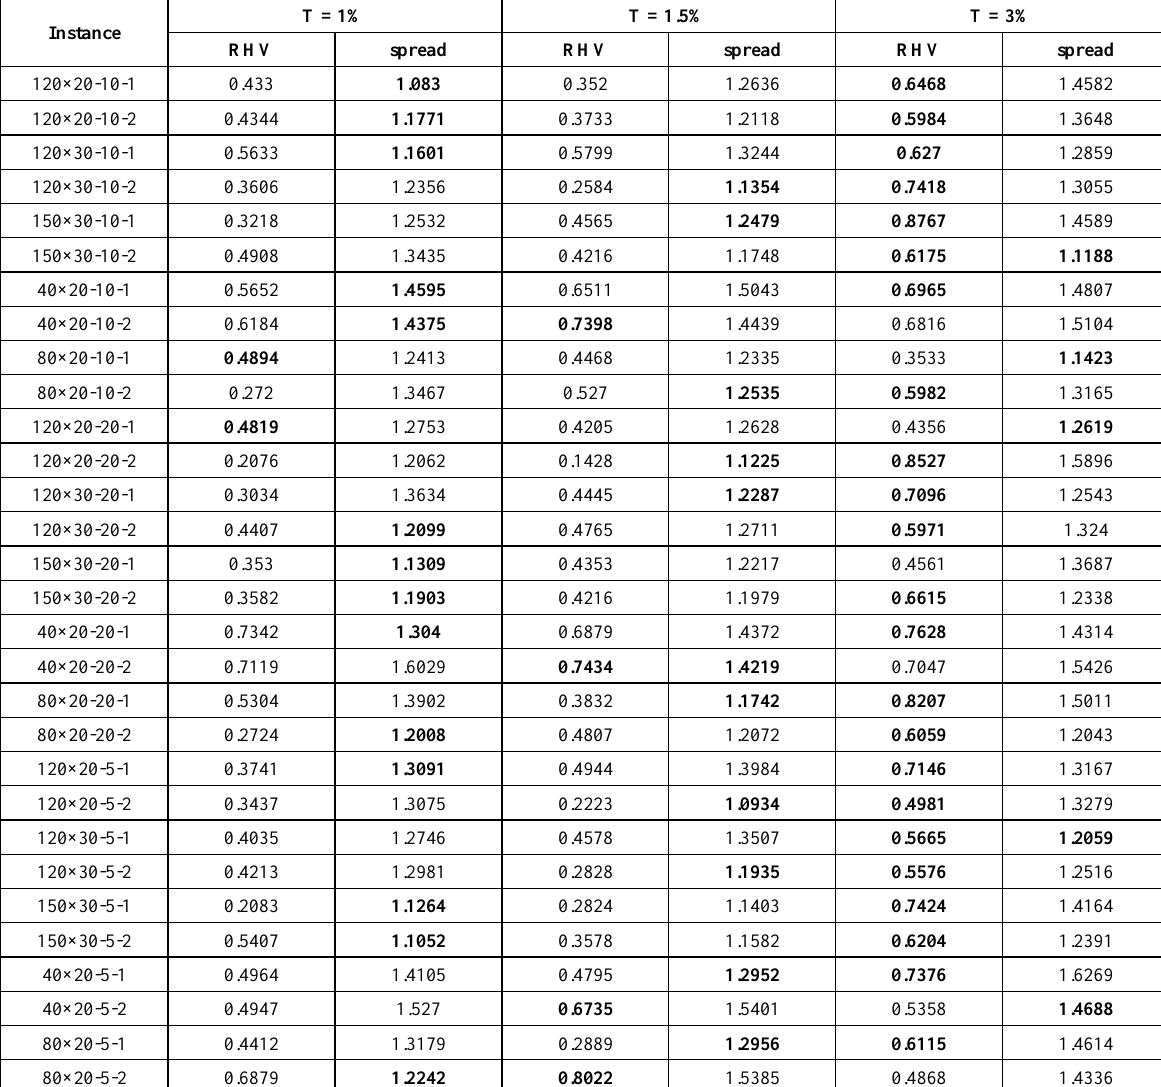
Table 5. Results of the consolidated Pareto fronts metric for each